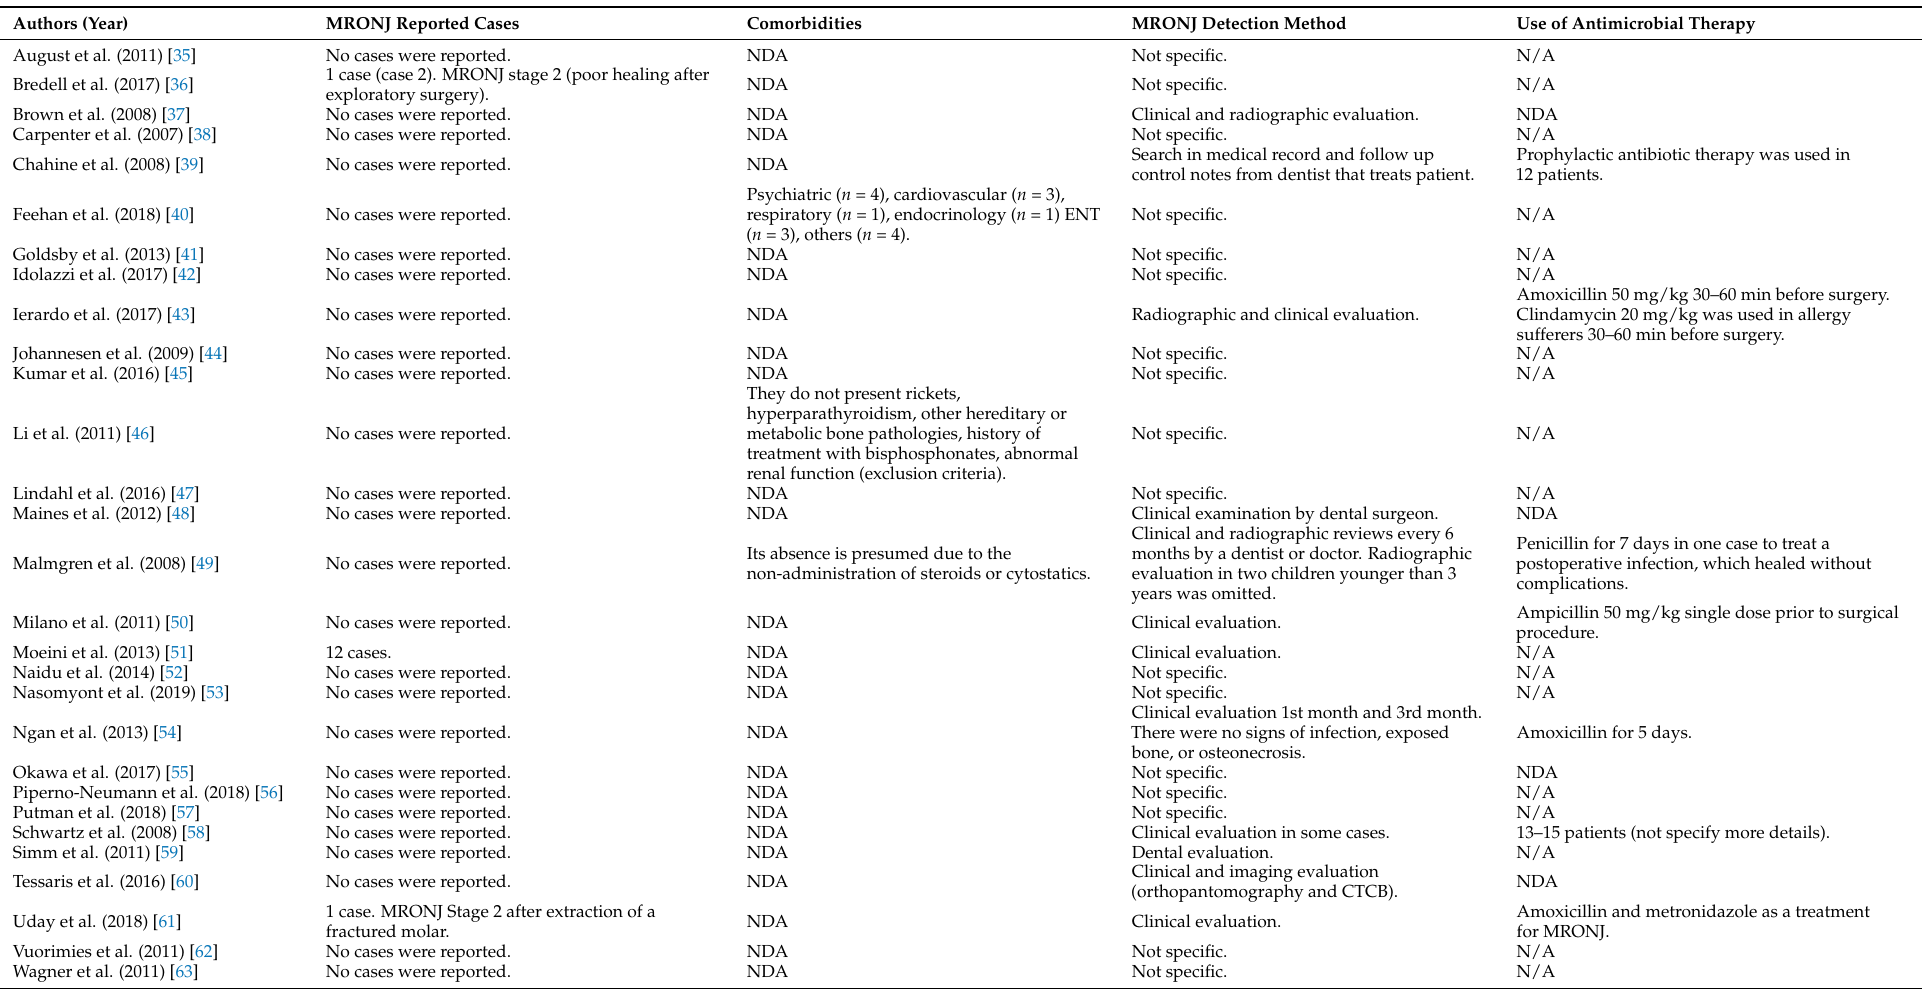
Table 2. Presence of MRONJ and comorbidities in the articles included in this systematic